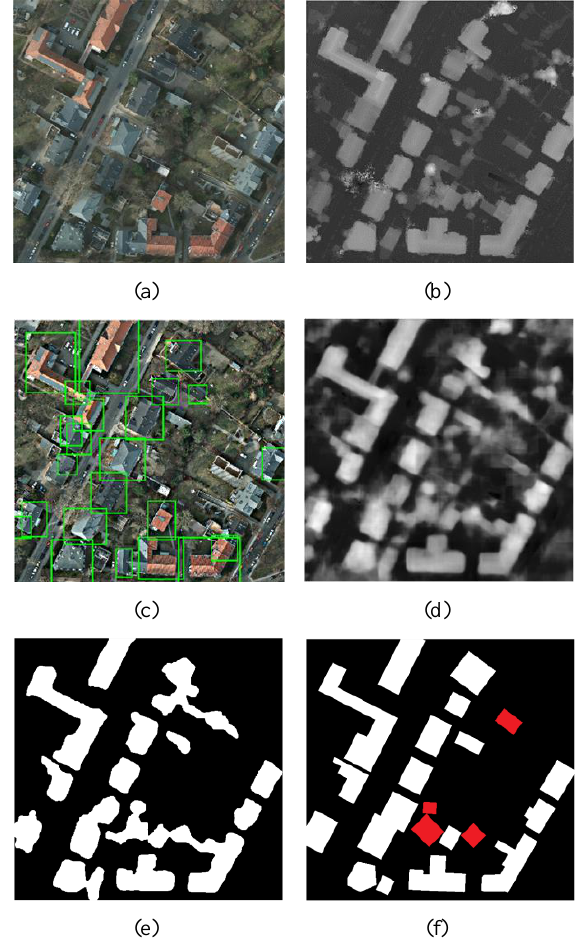
Figure 5. The test data and the results: a) the test RGB image, b) the ground truth nDSM, c) the detected buildings and bounding boxes, d) the predicted nDSM, e) the ACM’s output, and f) the